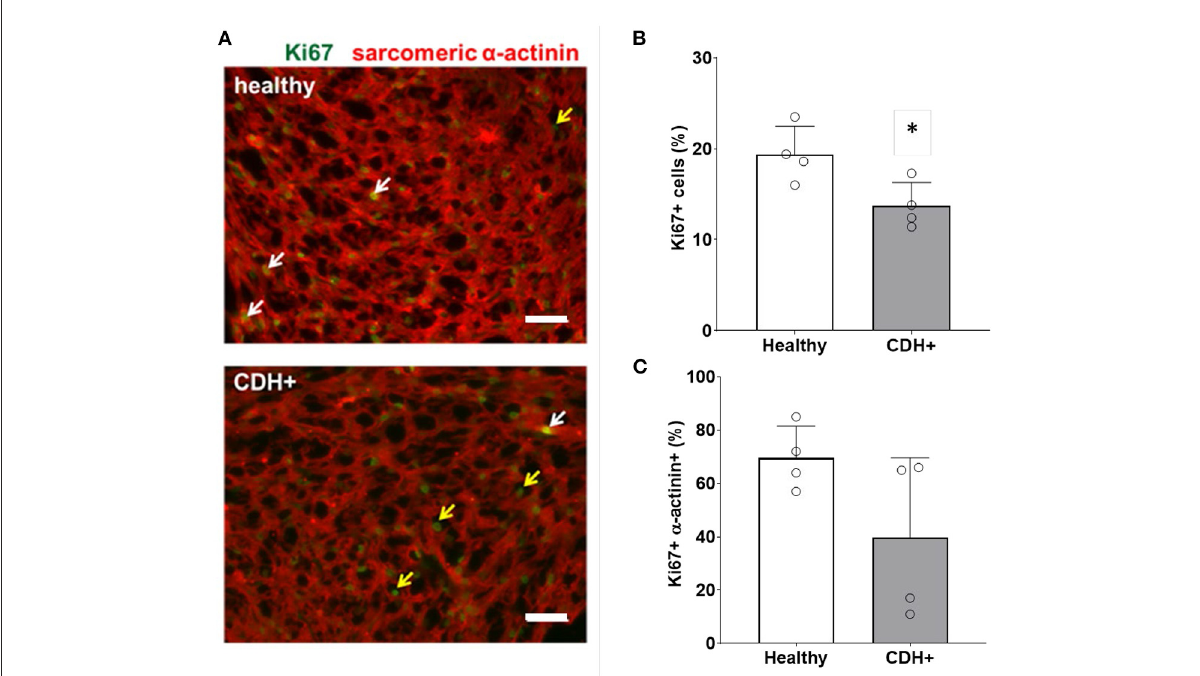
FIGURE2 Proliferation measurements in healthy and CDH + hearts. (A) E21 heart sections stained for Ki67 (green) and sarcomeric α -actinin (red); examples of Ki67 + cardiomyocytes (white arrows), Ki67 + non-myocytes (yellow arrows), scale bars = 50 µ m. (B) Total cell proliferation shown as percent of cells expressing Ki67. * Denotes p < 0.05. (C) Cardiomyocyte-specific proliferation (the percentage of Ki67 + cells that were also α -actinin +